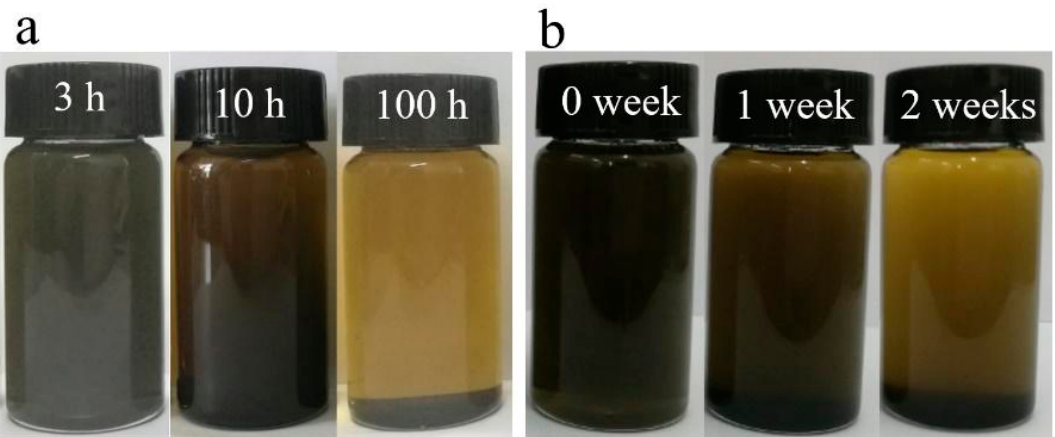
Figure 6. Photographs of blended lubricating oil containing ( a ) graphene obtained 3 h, 10 h, 100 h after sonication and ( b ) graphene oxide 0 week, 1 week, 2 weeks after sonication at room